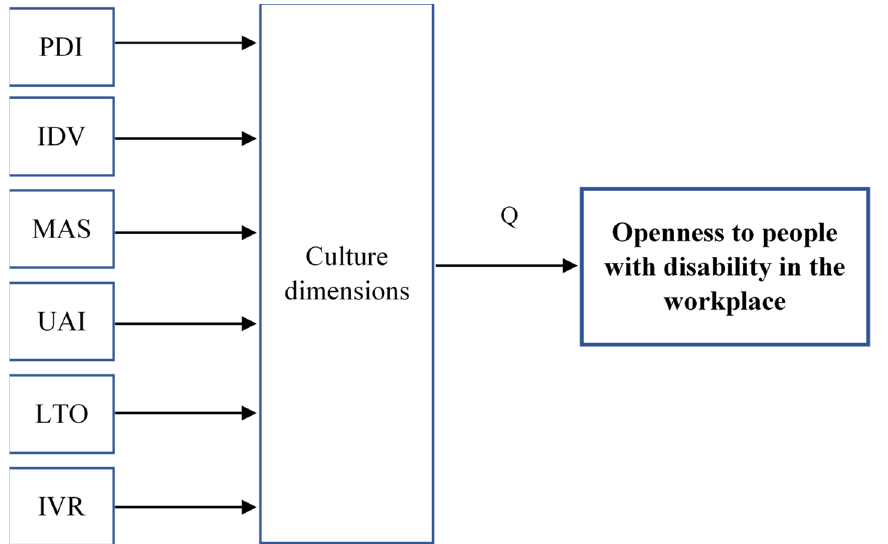
Figure 1. Conceptual model of influence of culture dimensions on the openness towards PwD in the workplace.